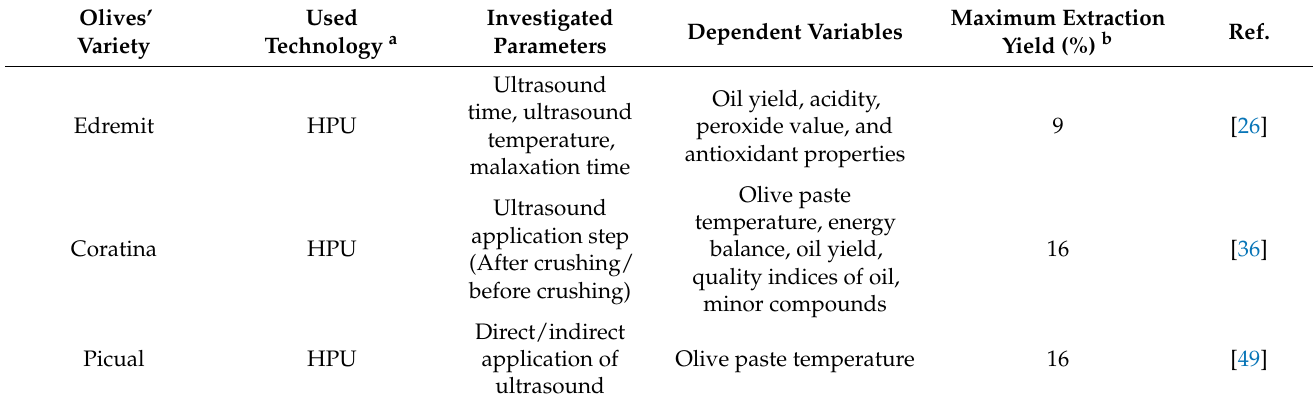
Table 1. Emerging extraction methods for olive oil production. Adapted from Ref.